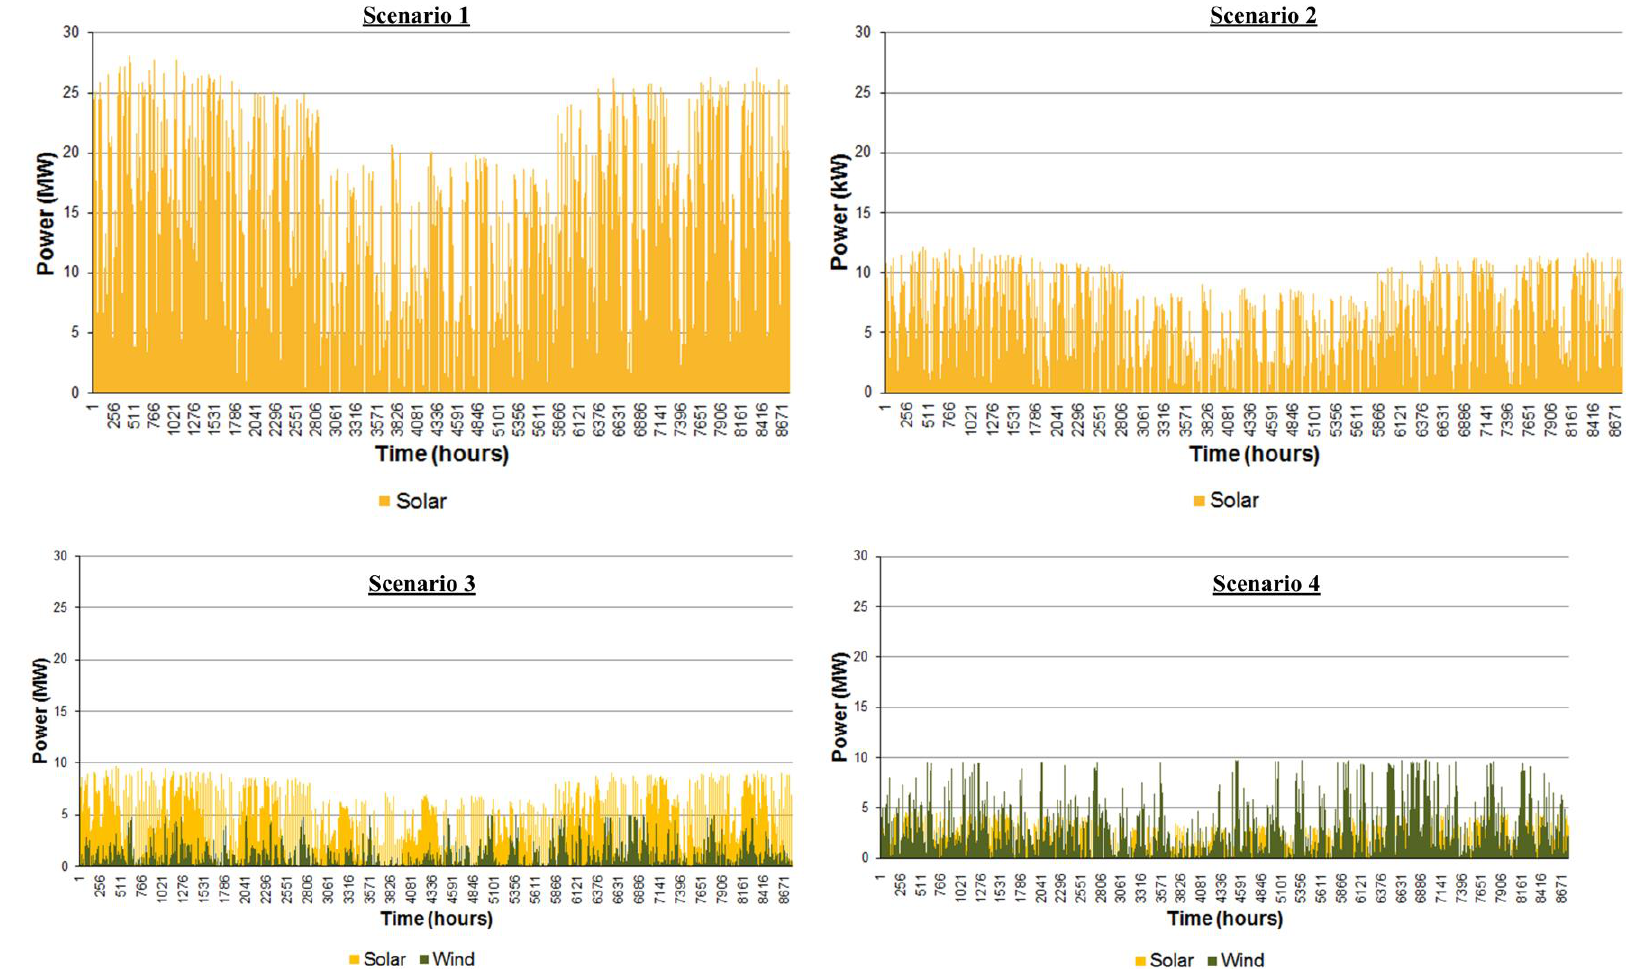
Figure 7. Hourly electric power production at each scenario